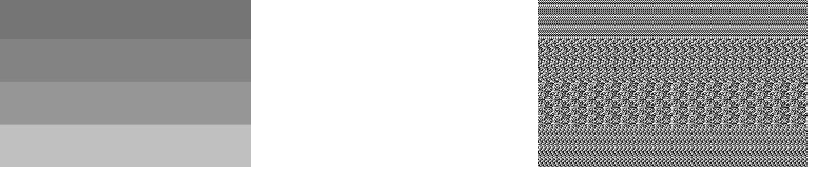
Figure 3. The similar statistical characteristics in the original image and block-based cipher image using convergent